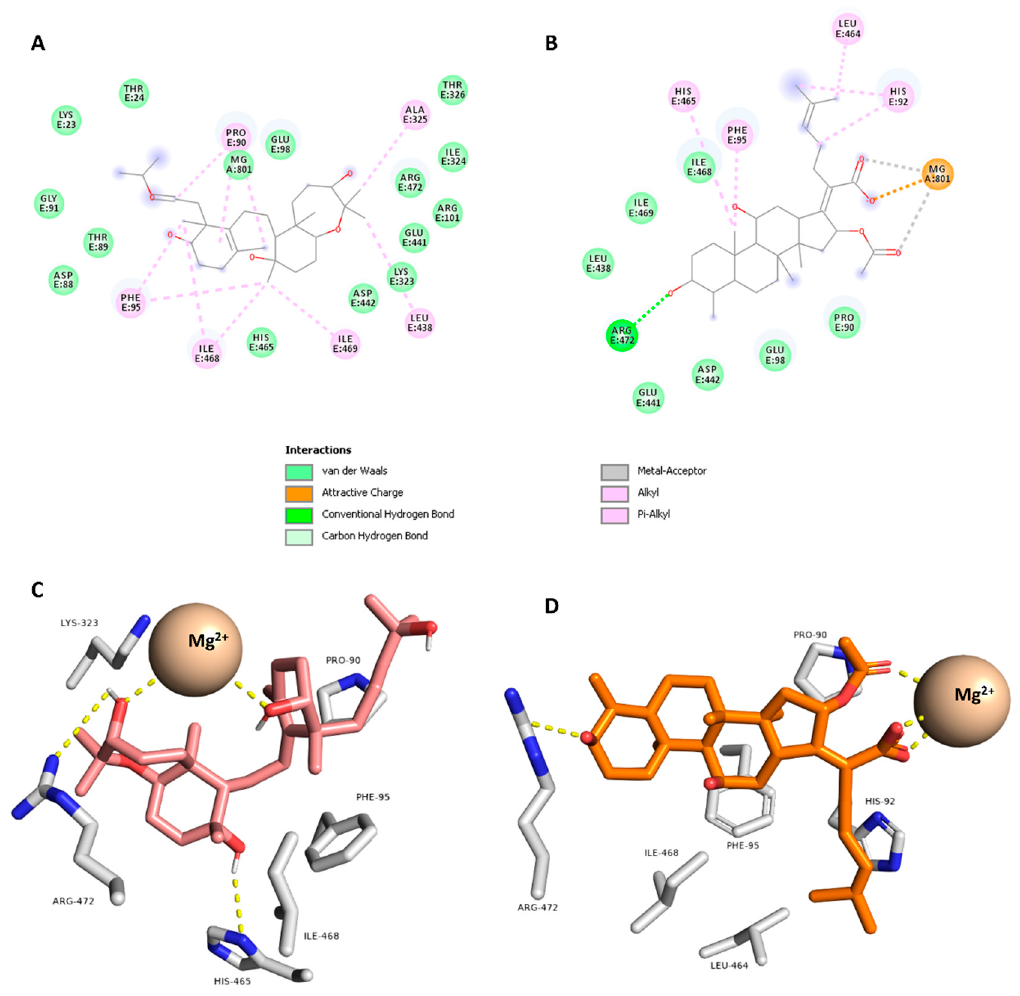
Figure 3. Binding mode of compound 11 and fusidic acid inside the binding site of EF-G (PDB ID: 7N2C) using 2D ( A and B , respectively) and 3D representations ( C and D , respectively).